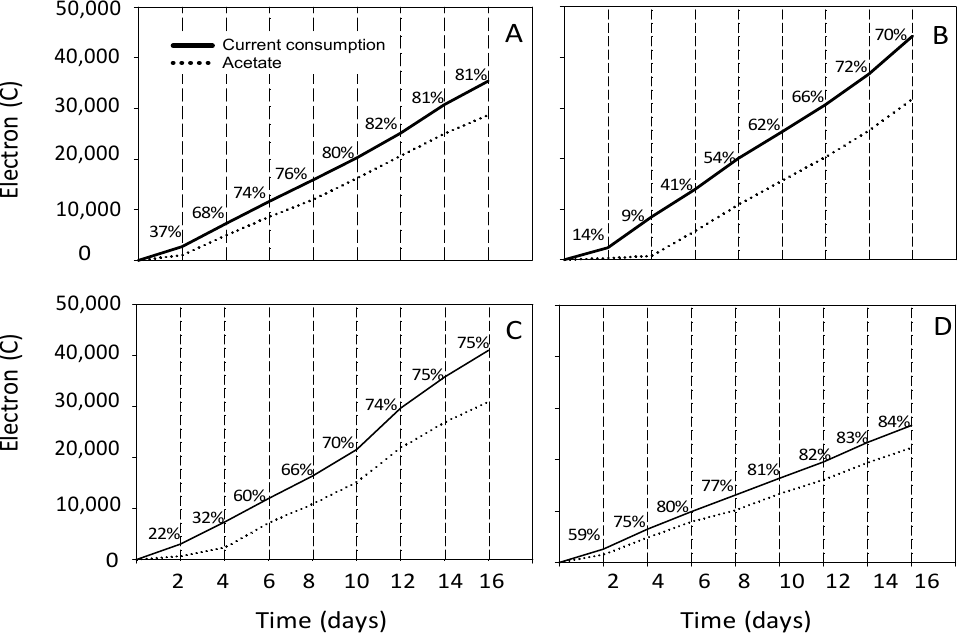
Figure 2. Electron recovery into acetate at 0.1 mM redox mediators. ( A ) Control, ( B ) NR, ( C ) HNQ, ( D ) HQ. Dotted line represents each cycle.